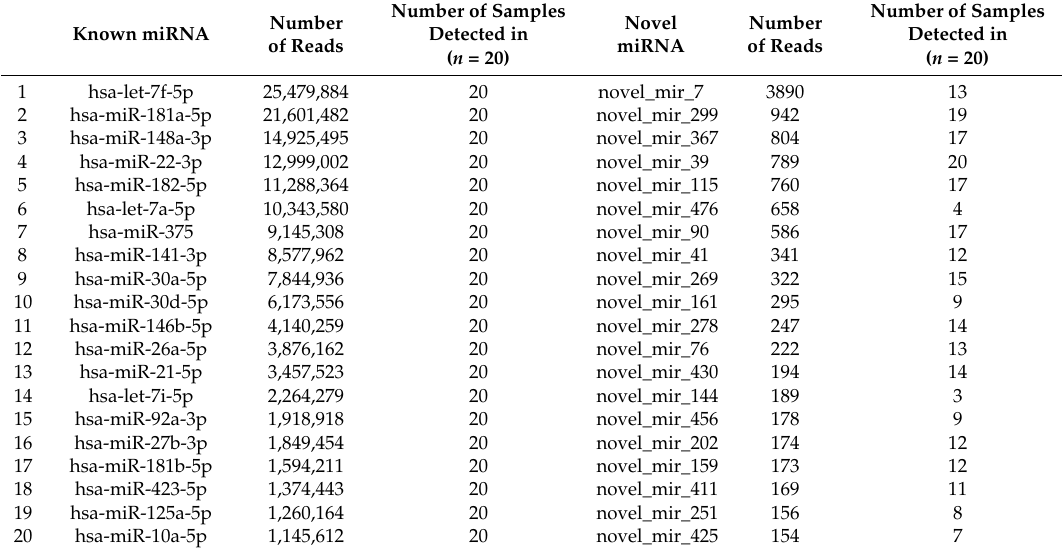
Table 4. Top 20 most highly expressed known and novel miRNAs across all 20 pre- and post-feed milk samples with the total reads, and the number of samples that each miRNA was detected in. Number Known miRNA of Reads